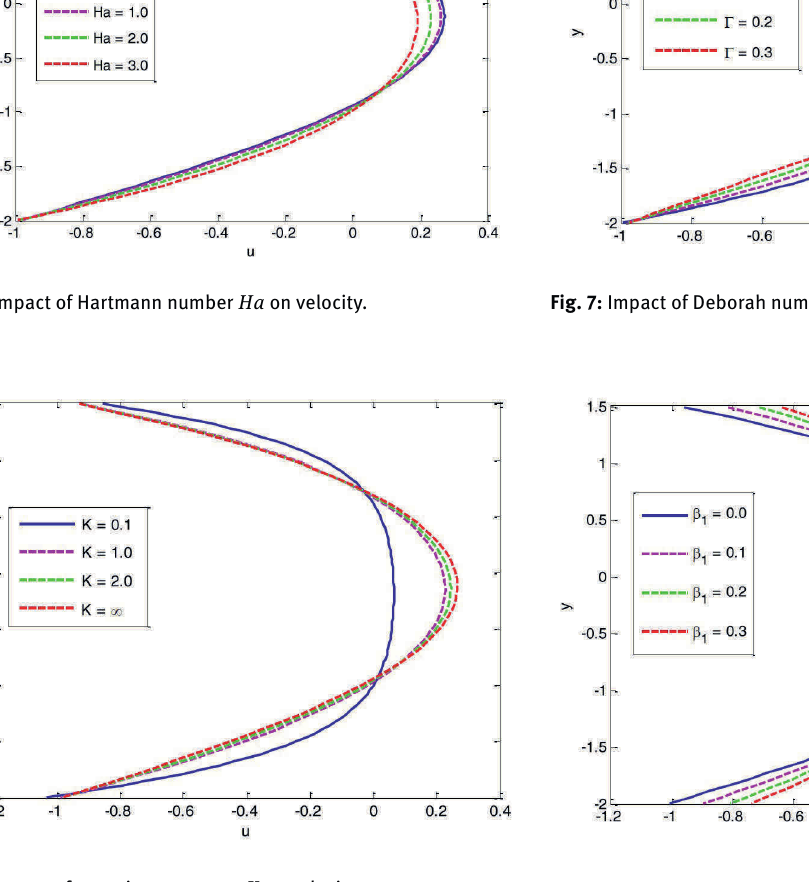
Fig. 8: Impact of first order velocity slip parameter β 1 on velocity.